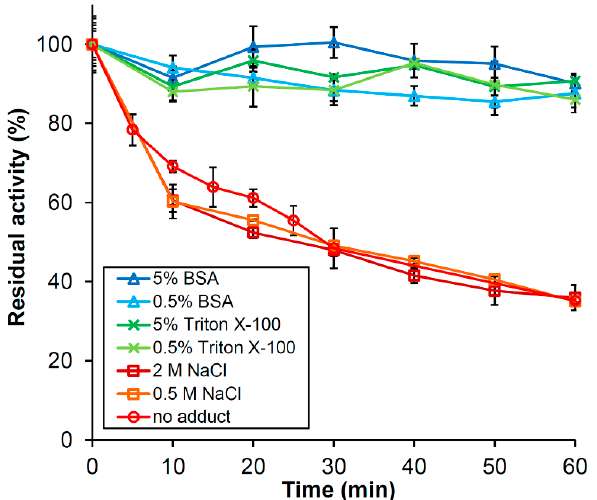
Figure 4. Effect of bovine serum albumin ( BSA), Triton X-100, and NaCl on the stability of 5 µg·mL − 1 Ph Nah20A on ice. The retained activity was measured at 37 °C in McIlvaine buffer, pH 6.0, using 2 mM p NPGlcNAc as the substrate. Ph Nah20A, BSA, NaCl and Triton X-100 were further 10 times diluted in the activity assay done at 0.5 µg mL − 1 Ph Nah20A, 0.05% or 0.5% BSA, 0.05% or 0.5% Triton X-100, 0.05 or 0.2 M NaCl. Int. J. Mol. Sci. 2020 , 21 , x